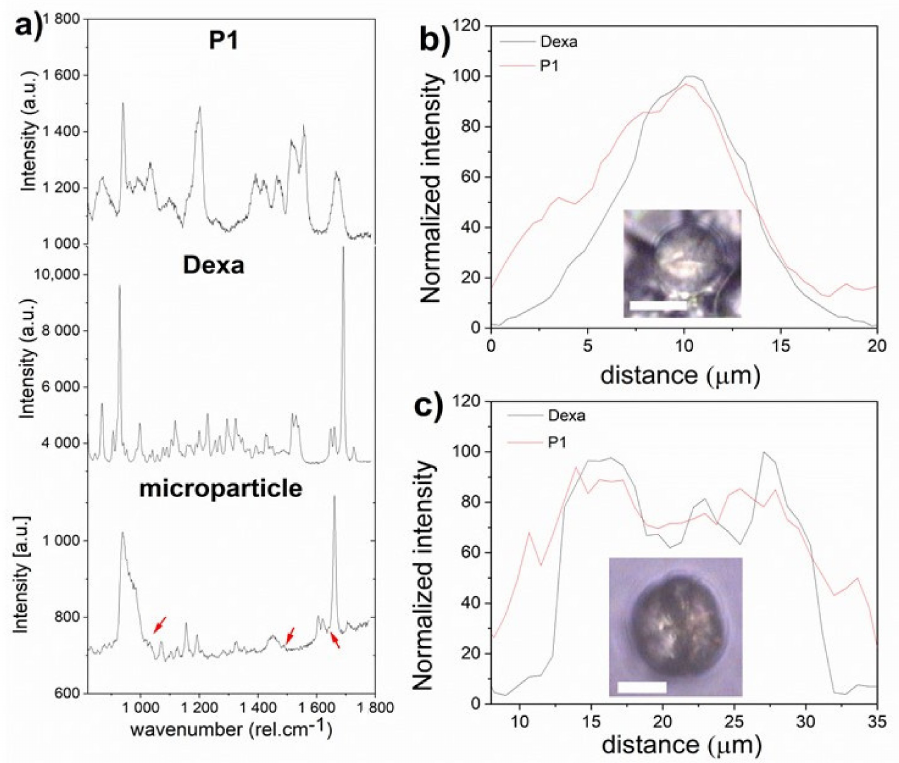
Figure 8. Raman spectra of polymer P1, Dexa, and microparticle are shown ( a ). The red arrows point on peaks corresponding to the polymer within the spectrum of the microparticle. The distribution of polymer and the drug within two particles is shown in ( b , c ). The white scale bar in the incorporated images represents 10 µ